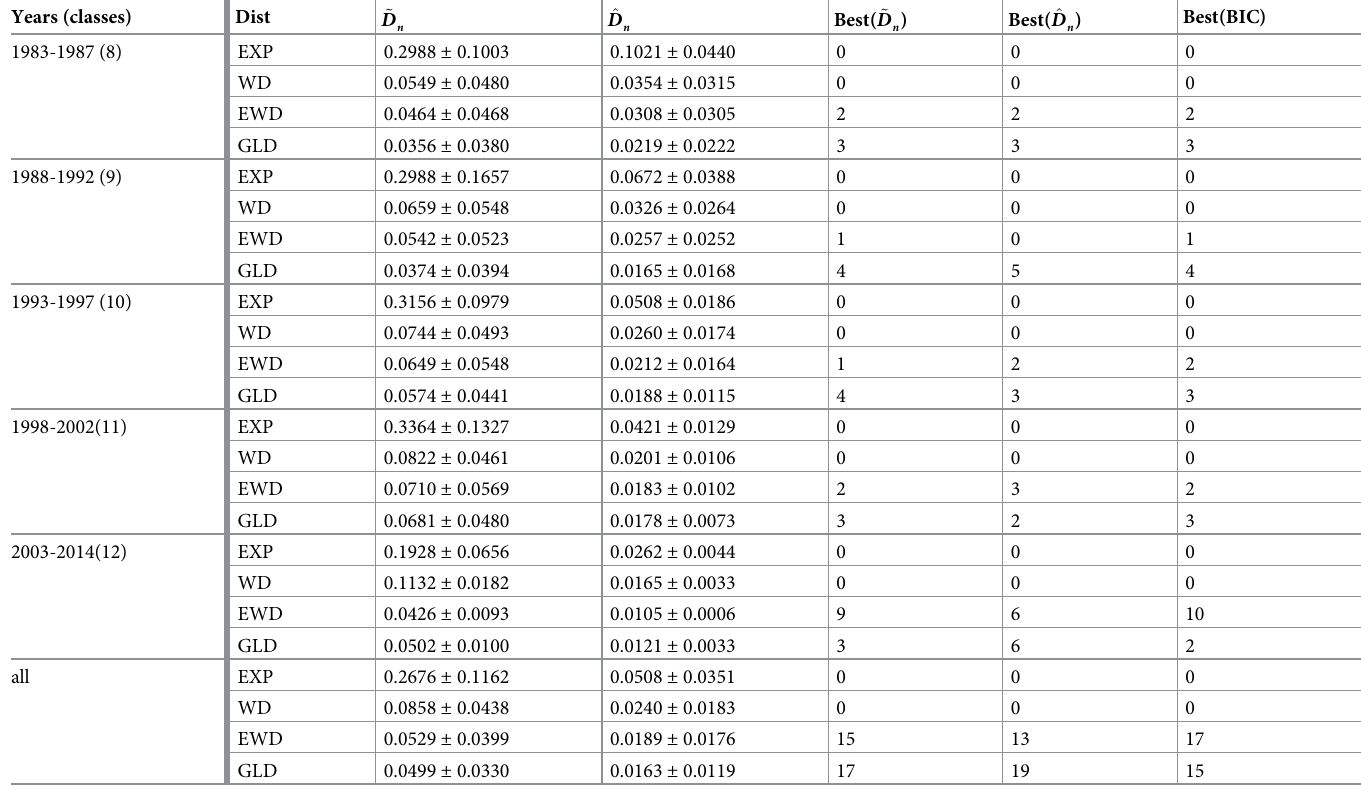
Table 4. Comparisons of goodness-of-fit to firm age